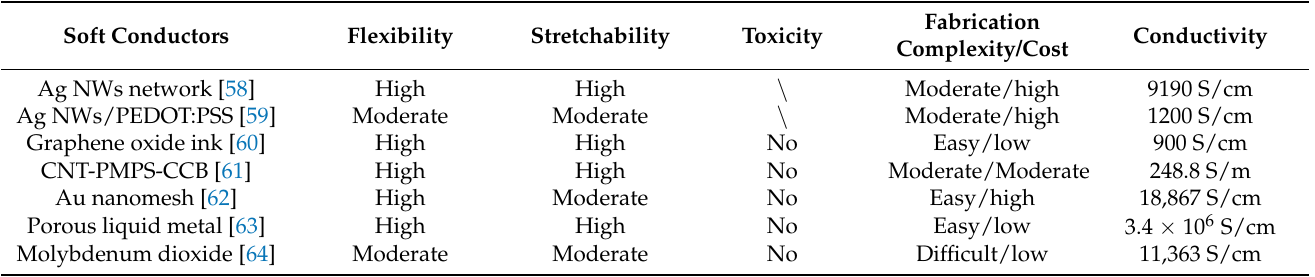
Table 2. Comparisons of mechanical and electrical properties and fabrication difficulties of different nanomaterial-based